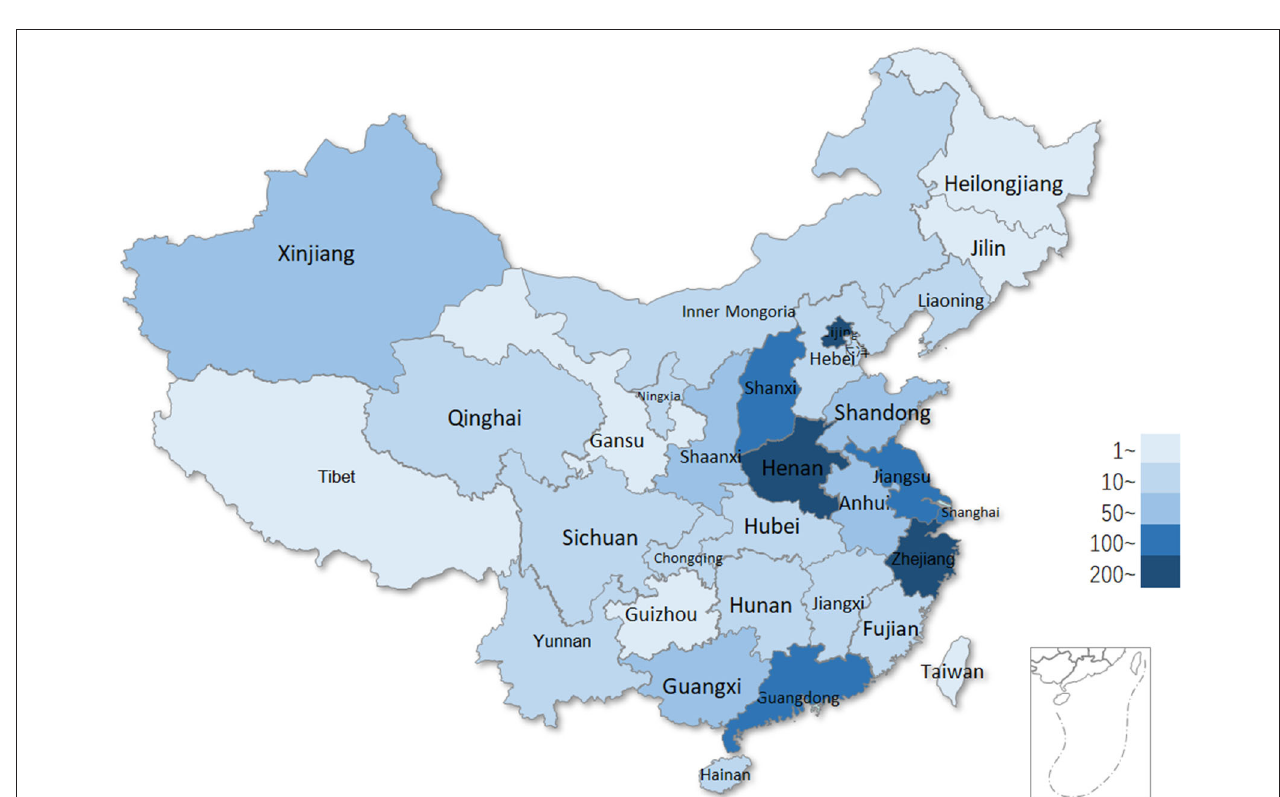
FIGURE 7 | Geographical distribution of